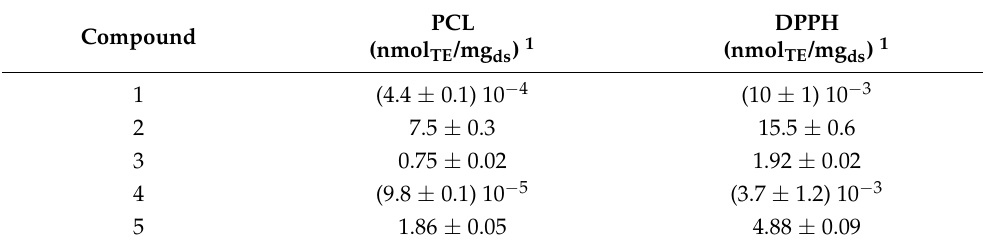
Table 2. Antioxidant activities of the products 3 and 5 and of the reagents 1 , 2, and 4